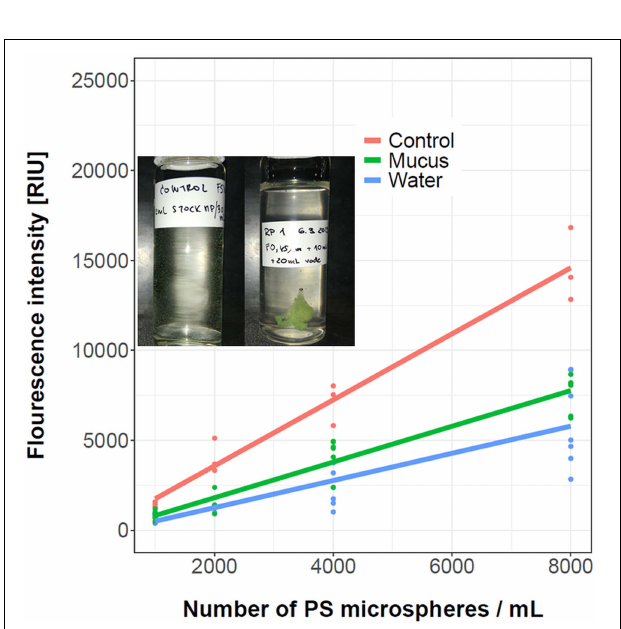
FIGURE 4 | Fluorescence intensity of the control microspheres suspension (red). The green line shows microspheres sequestered in mucus (30 mg/mL), and the blue line shows residual fluorescence due to microspheres remaining in the surrounding water. The measurements are denoted with dots, while a linear regression fit is represented with a line. In the inset the mucus prior (left) and after the addition of PS microspheres aggregates (right) is shown. The number of replicates for control treatments was three, while for mucus samples between five and seven replicates were used for each treatment, as indicated by colored